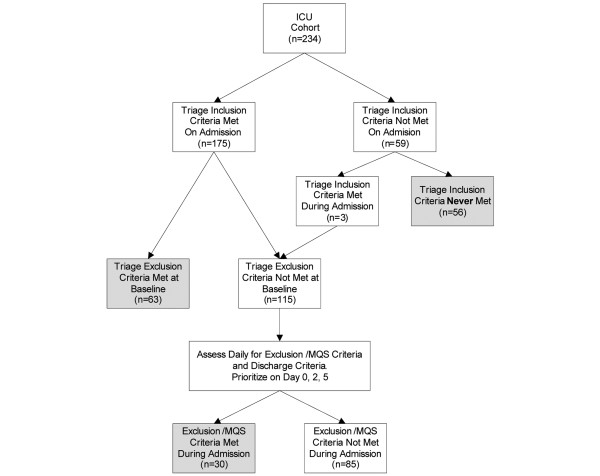
Triage process flow. ICU = intensive care unit; MQS = minimum qualifications for survival.